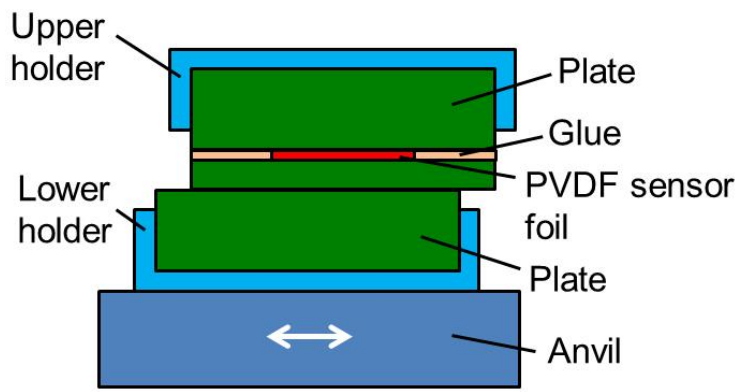
Figure 21. PVDF sensor foil glued between two plates .